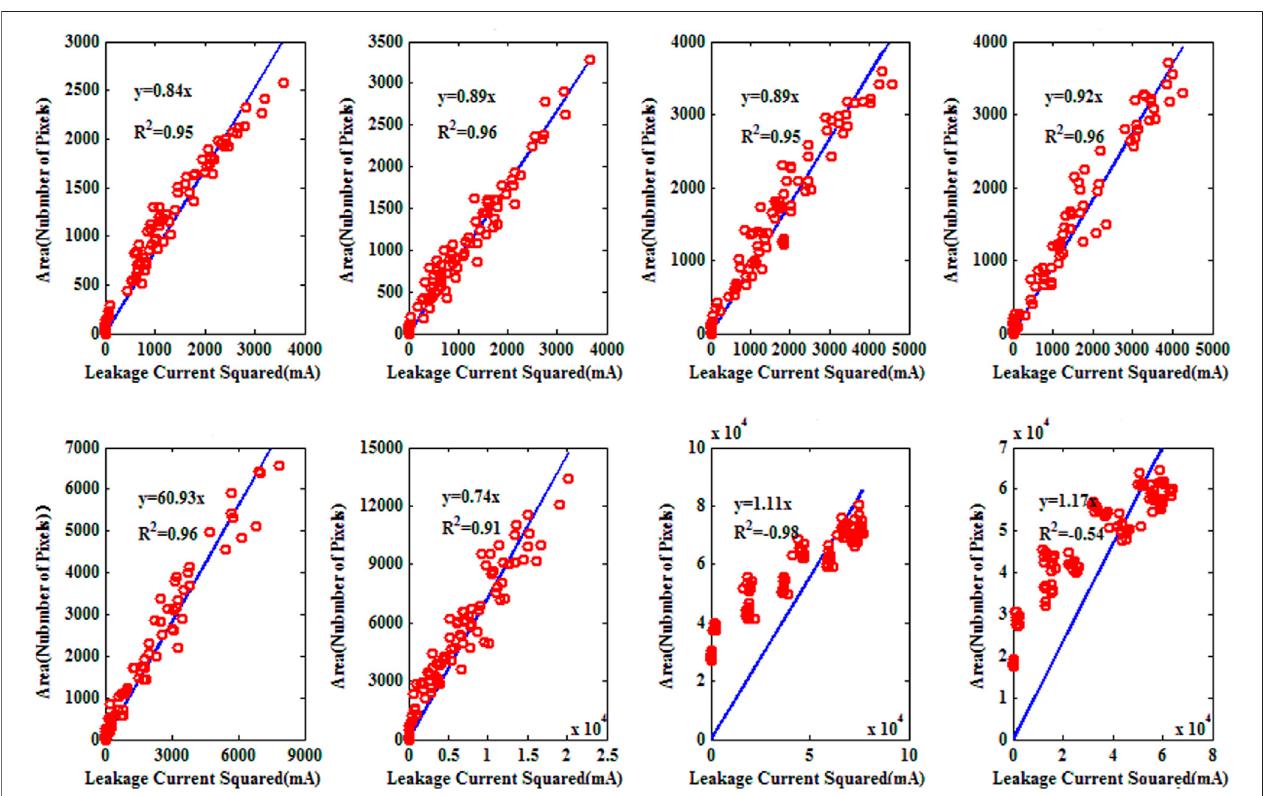
FIGURE 7 | Relation between leakage current squared and the arc